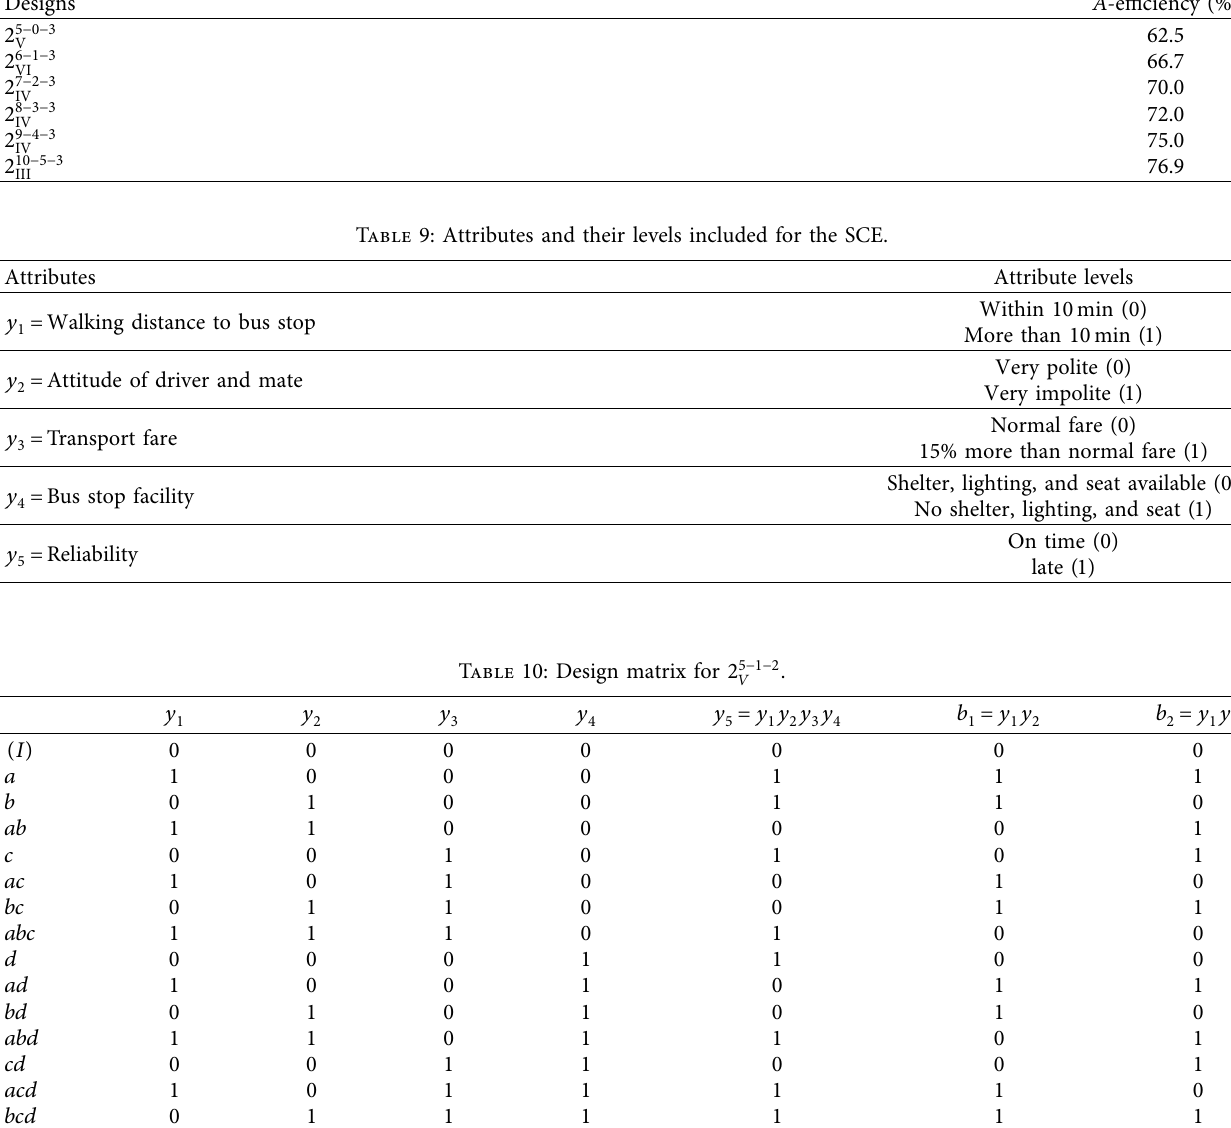
Table 11: A choice set one for 2 5 − 1 − 2